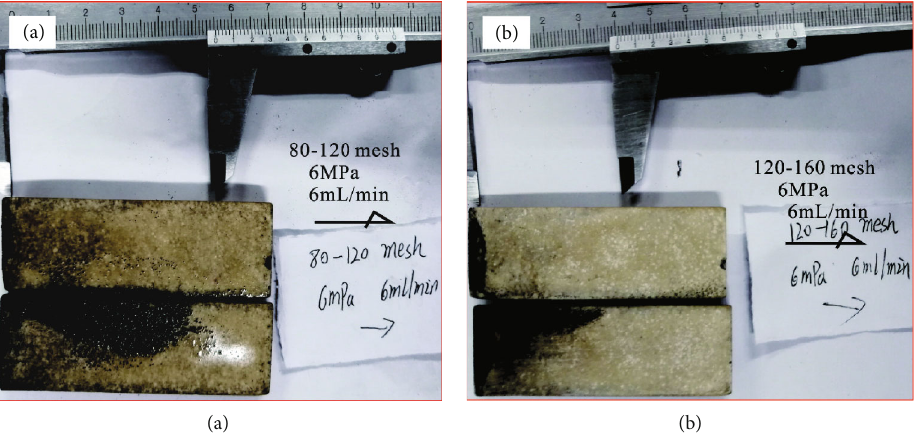
Figure 7: The characteristic of coal fi nes intrusion under di ff erent coal fi nes size. (a) The condition: coal fi nes size of 80-120 mesh, fl ow velocity of 6mL/min, and con fi ning pressure of 6MPa. (b) The condition: coal fi nes size of 120-160 mesh, fl ow velocity of 6 mL/min, and con fi ning pressure of 6